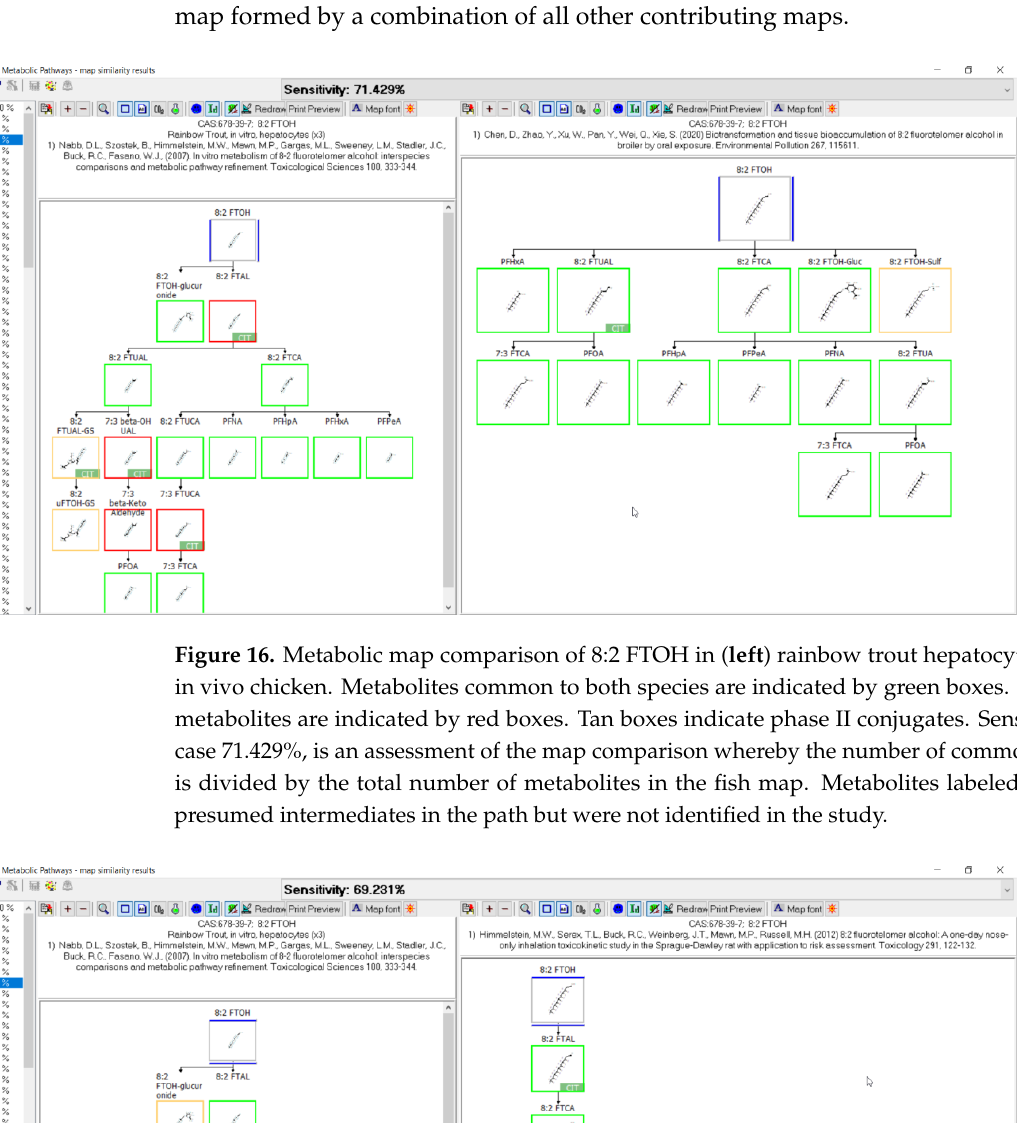
Figure 18. Metabolic map comparison of 8:2 FTOH in ( left ) rainbow trout hepatocytes and ( right ) in vivo pig. Metabolites common to both species are indicated by green boxes. Differences in me- tabolites are indicated by red boxes. Tan boxes indicate phase II conjugates. Sensitivity, in this case 69.231%, is an assessment of the map comparison whereby the number of common metabolites is divided by the total number of metabolites in the fish map. Metabolites labeled with CIT are pre- sumed intermediates in the path but were not identified in the study.